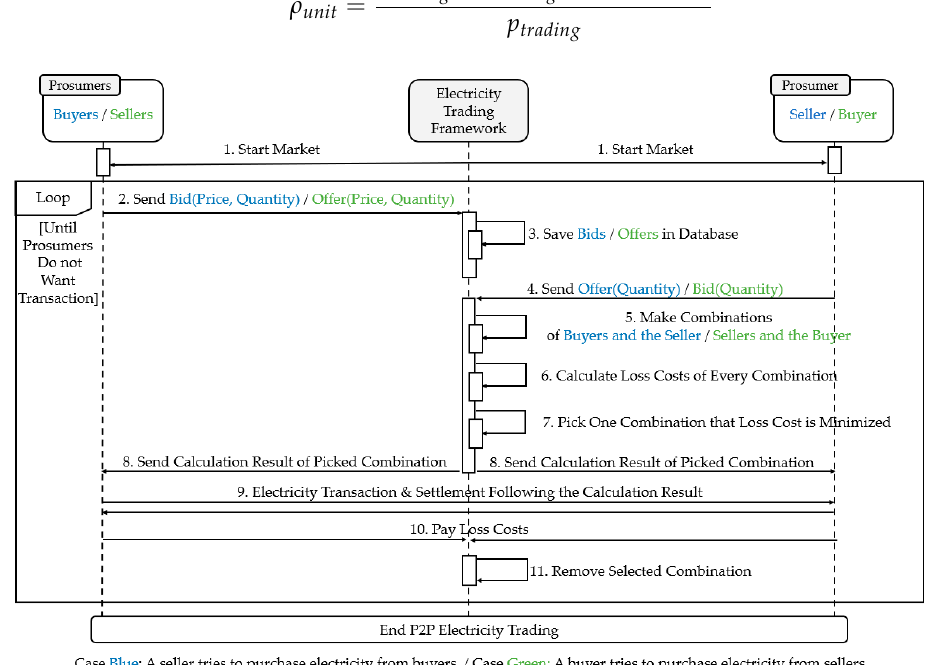
Figure 2. Sequence diagram of the price-guided P2P trading.